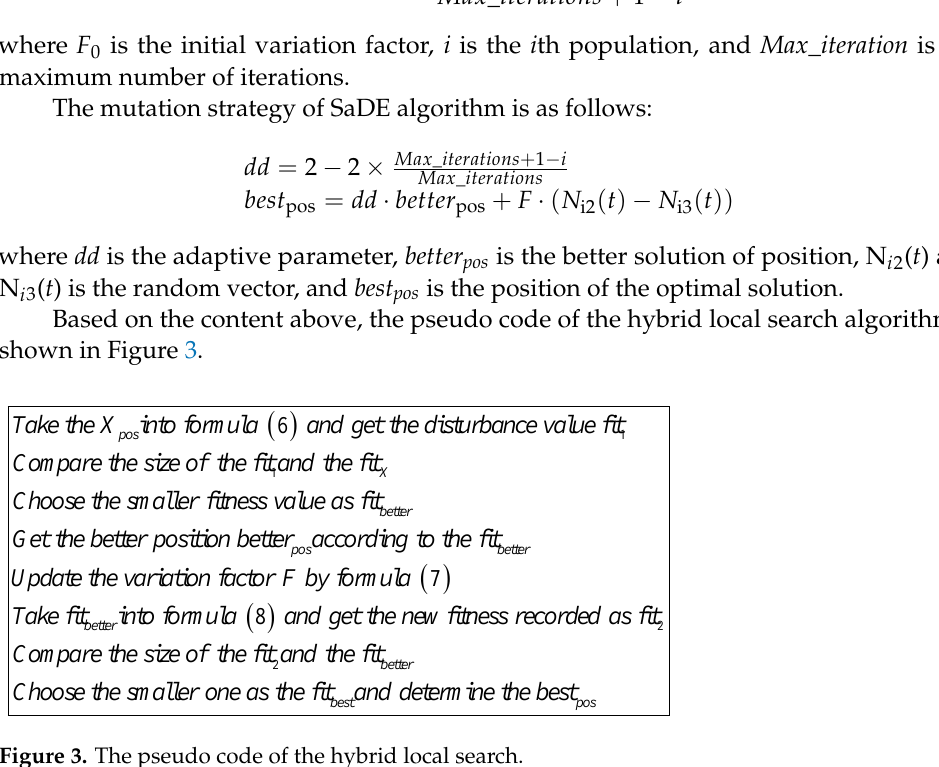
Figure 3. The pseudo code of the hybrid local search.